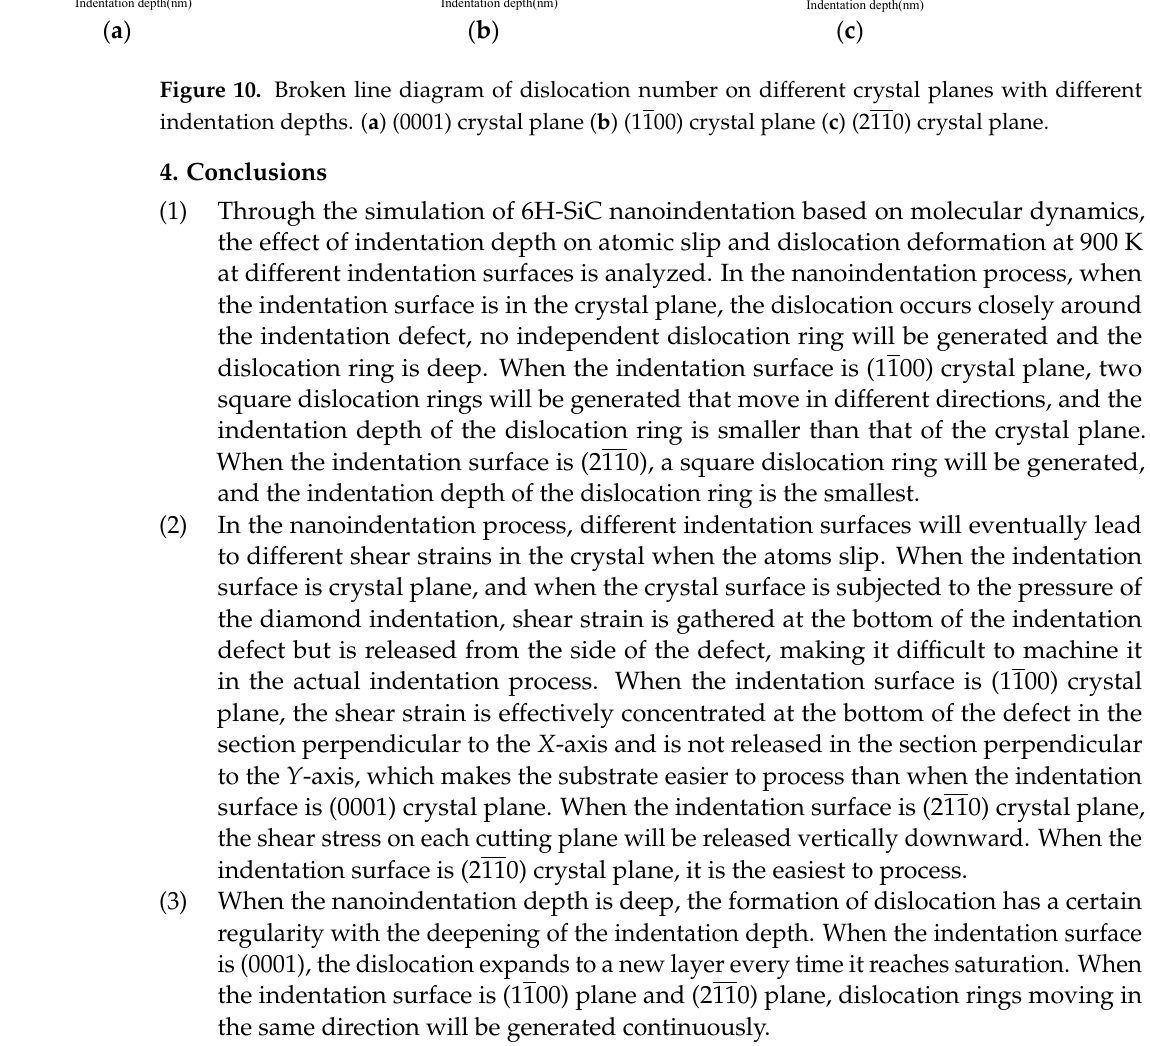
—— 0) crystal plane.